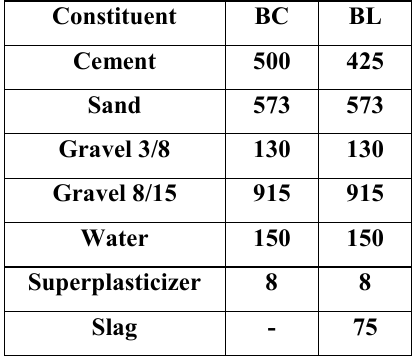
Composition of concretes with and without slag (kg/m 3 ).